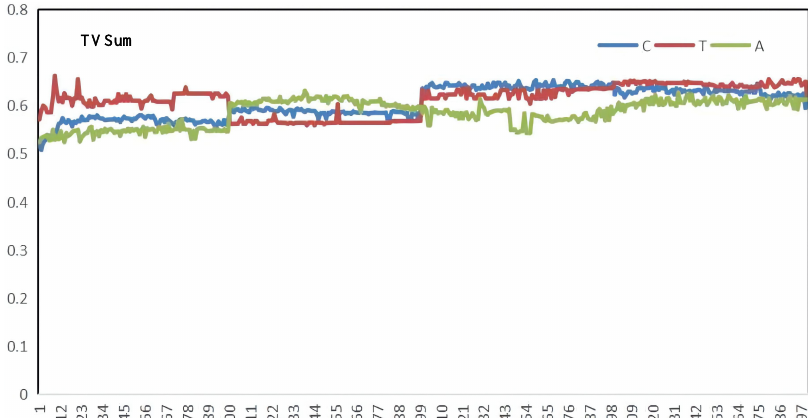
Figure 8. The A, C, and T results of SumMe.